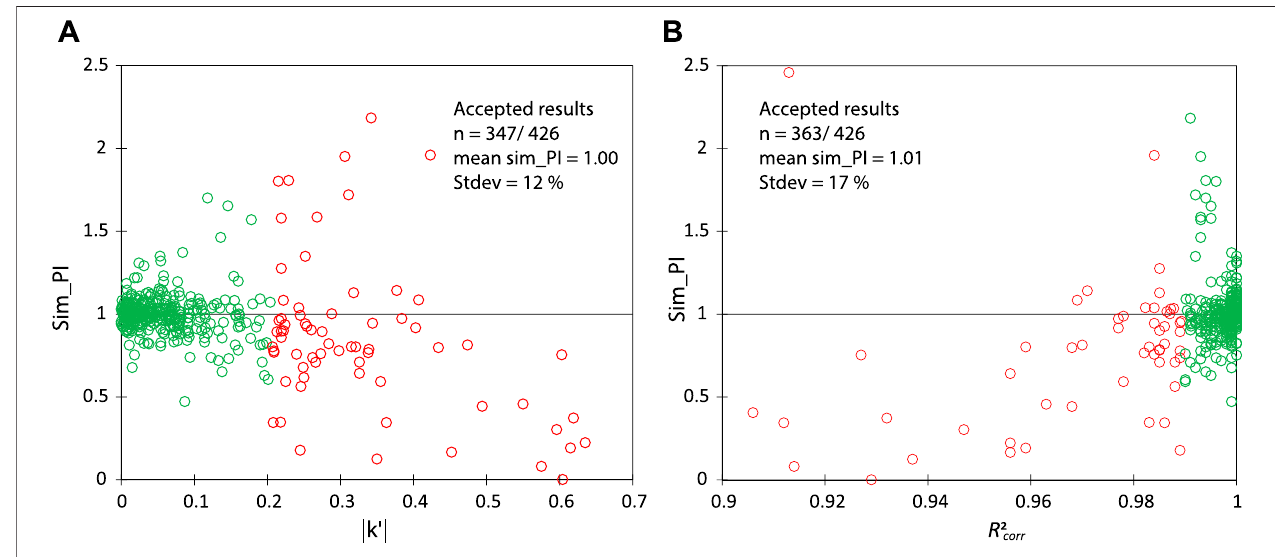
FIGURE2| Thefulldatasetof426simulatedpalaeointensityresultsareplottedagainstlinearityparameters|k ′ | (A) andR 2 corr (B) .Here,nobaseselectioncriteria( Table2 )are appliedbeforeweplotthedata,therefore,thevaluesinthese fi guresdifferslightlytothosein Table3 .Greencircles,acceptedresultsattheselectedminima;redcircles,rejected results at |k ′ | ≥ 0.2 and R 2 corr ≤ 0.990. A few rejected results are not observed as they are outliers, falling outside the selected scale.